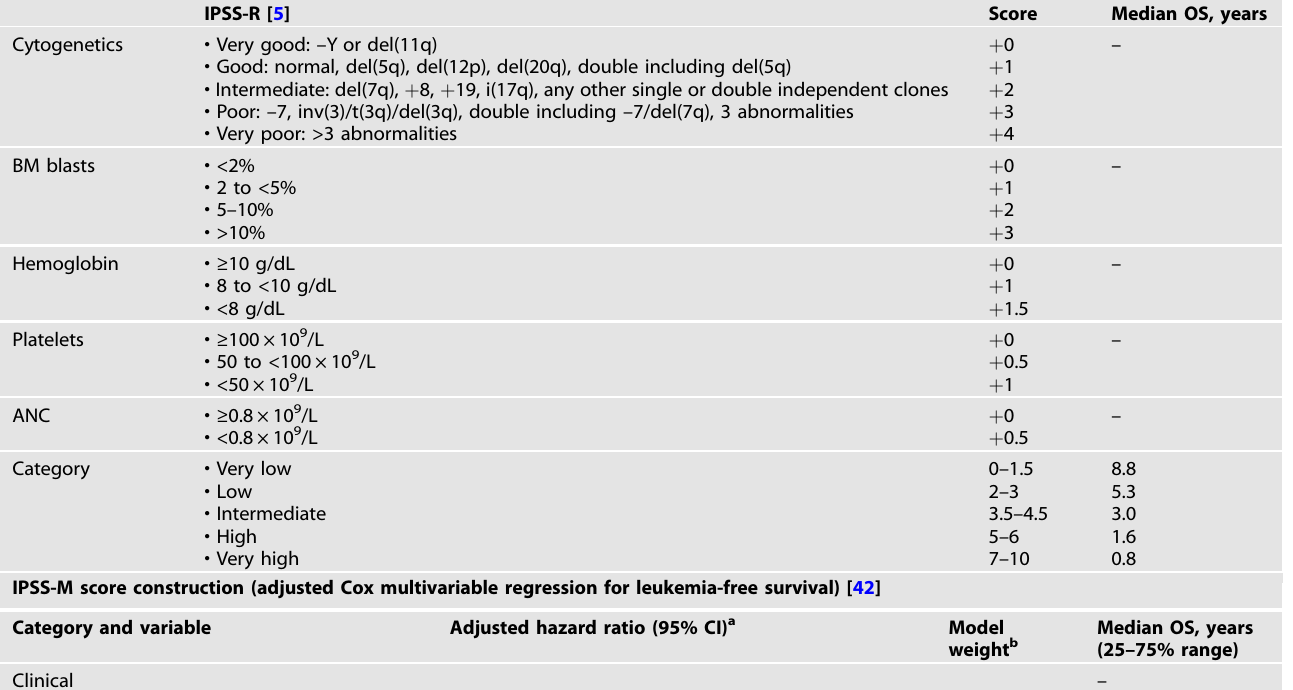
Table 3. IPSS-R and IPSS-M prognostic scoring and median OS by risk categories. IPSS-R [5] Score Median OS, years